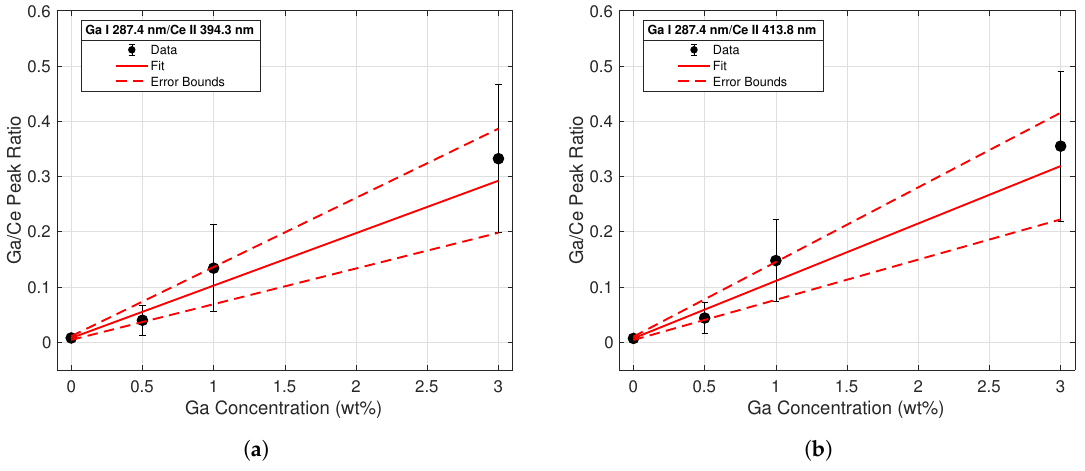
Figure 5. Calibration curve from line intensity ratios of the Ga I 287.4-nm emission to the ( a ) Ce II 394.3 nm ( b ) and the Ce II 413.8-nm emission lines. The regression fit is shown with a solid red line, while errors in the regression coefficients are plotted with the dashed red